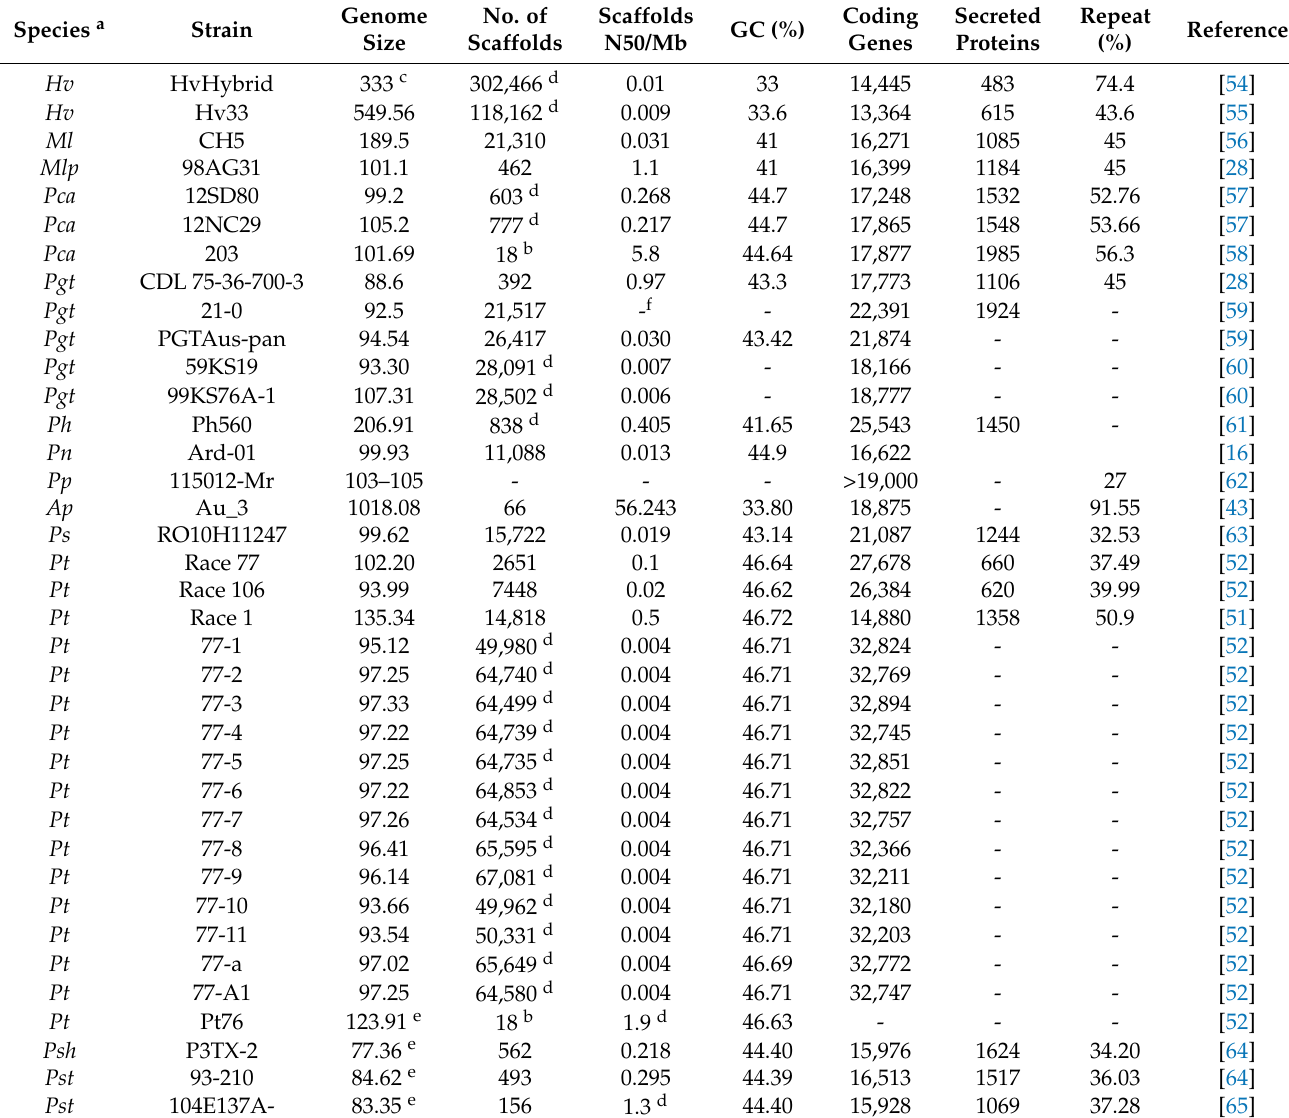
Table 2. Genomes of rust pathogens reviewed in this